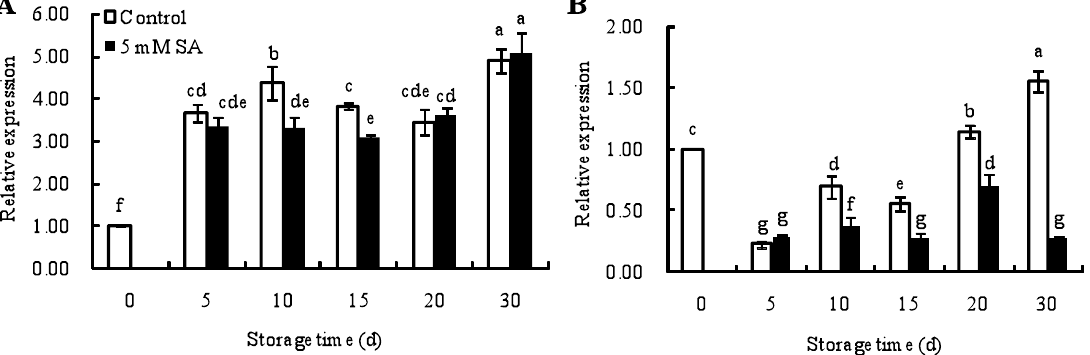
Fig. 6: Changes of relative expression level of LOX1 (A) and PLD4 (B) genes of peel in ‘Huangguan’ pear by SA treatment during cold storage. Values are mean ± SE of three replicates. Different letters represent significant differences at P = 0.05.